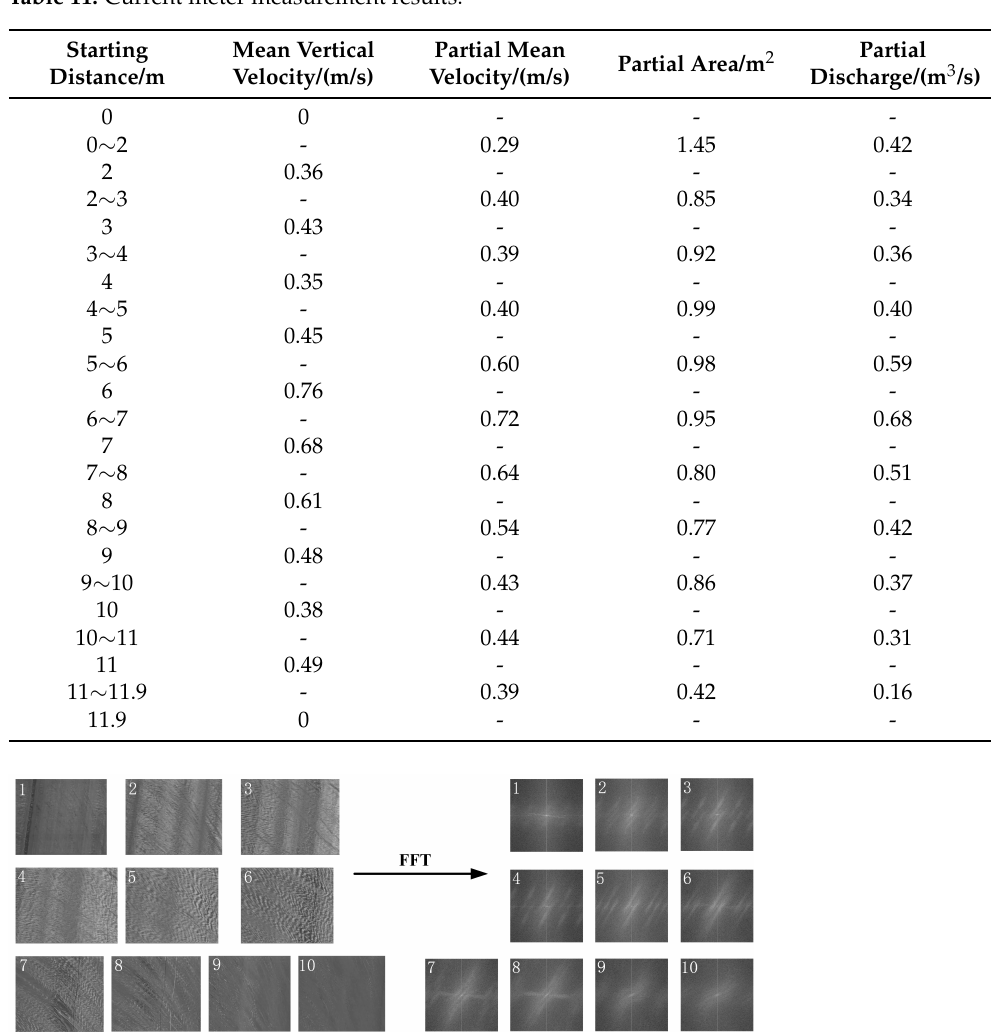
Table 11. Current meter measurement results.